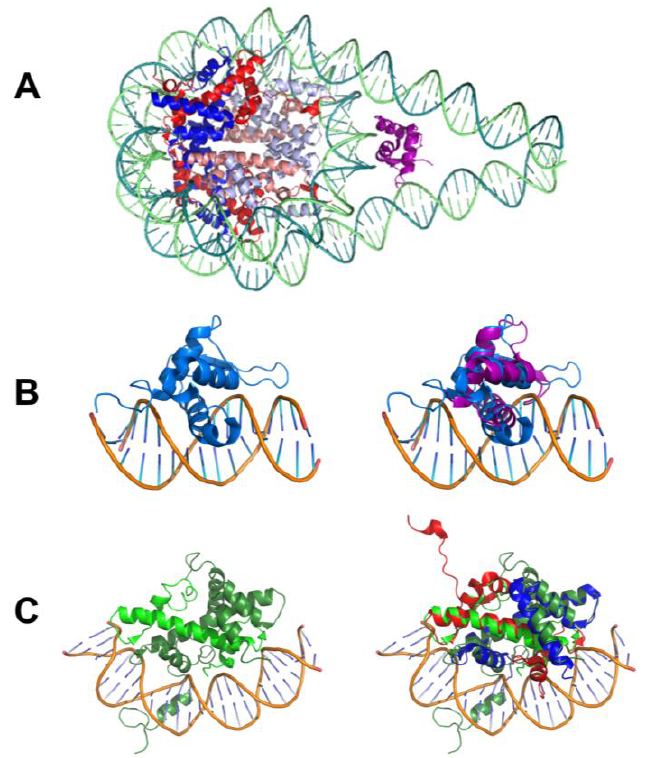
Figure 2. Structural comparison of histones and pioneer transcription factors (TF) showing histone mimicry. ( A ) Nucleosome structure including histone H1 (PDB 5NL0) shown as a cartoon with each histone colored uniquely — H1 in purple, H2A in red, H2B in blue, H3.2 in light blue and H4 in pink. H1 binds along the dyad axis, helping to stabilize the linker DNA. ( B ) Left, crystal structure of FOXO1 (PDB 3CO6) shown in blue bound to DNA. Right, overlay of FOXO1 (blue) and linker histone, H1 (purple). FOXO1 not only has the same fold as linker histone H1, but also binds DNA site specifically. ( C ) Left, structure of NF-Y transcription factor (PDB 4AWL) in complex with DNA. The protein subunits NF-YA, NF-YB and NF-YC are colored green and shown as a cartoon. Right, overlay of NF-Y (green) and histone H2A (red) and histone H2B (blue) dimer. NF-Y adopts the same fold as the H2A-H2B heterodimer while binding DNA site specifically.